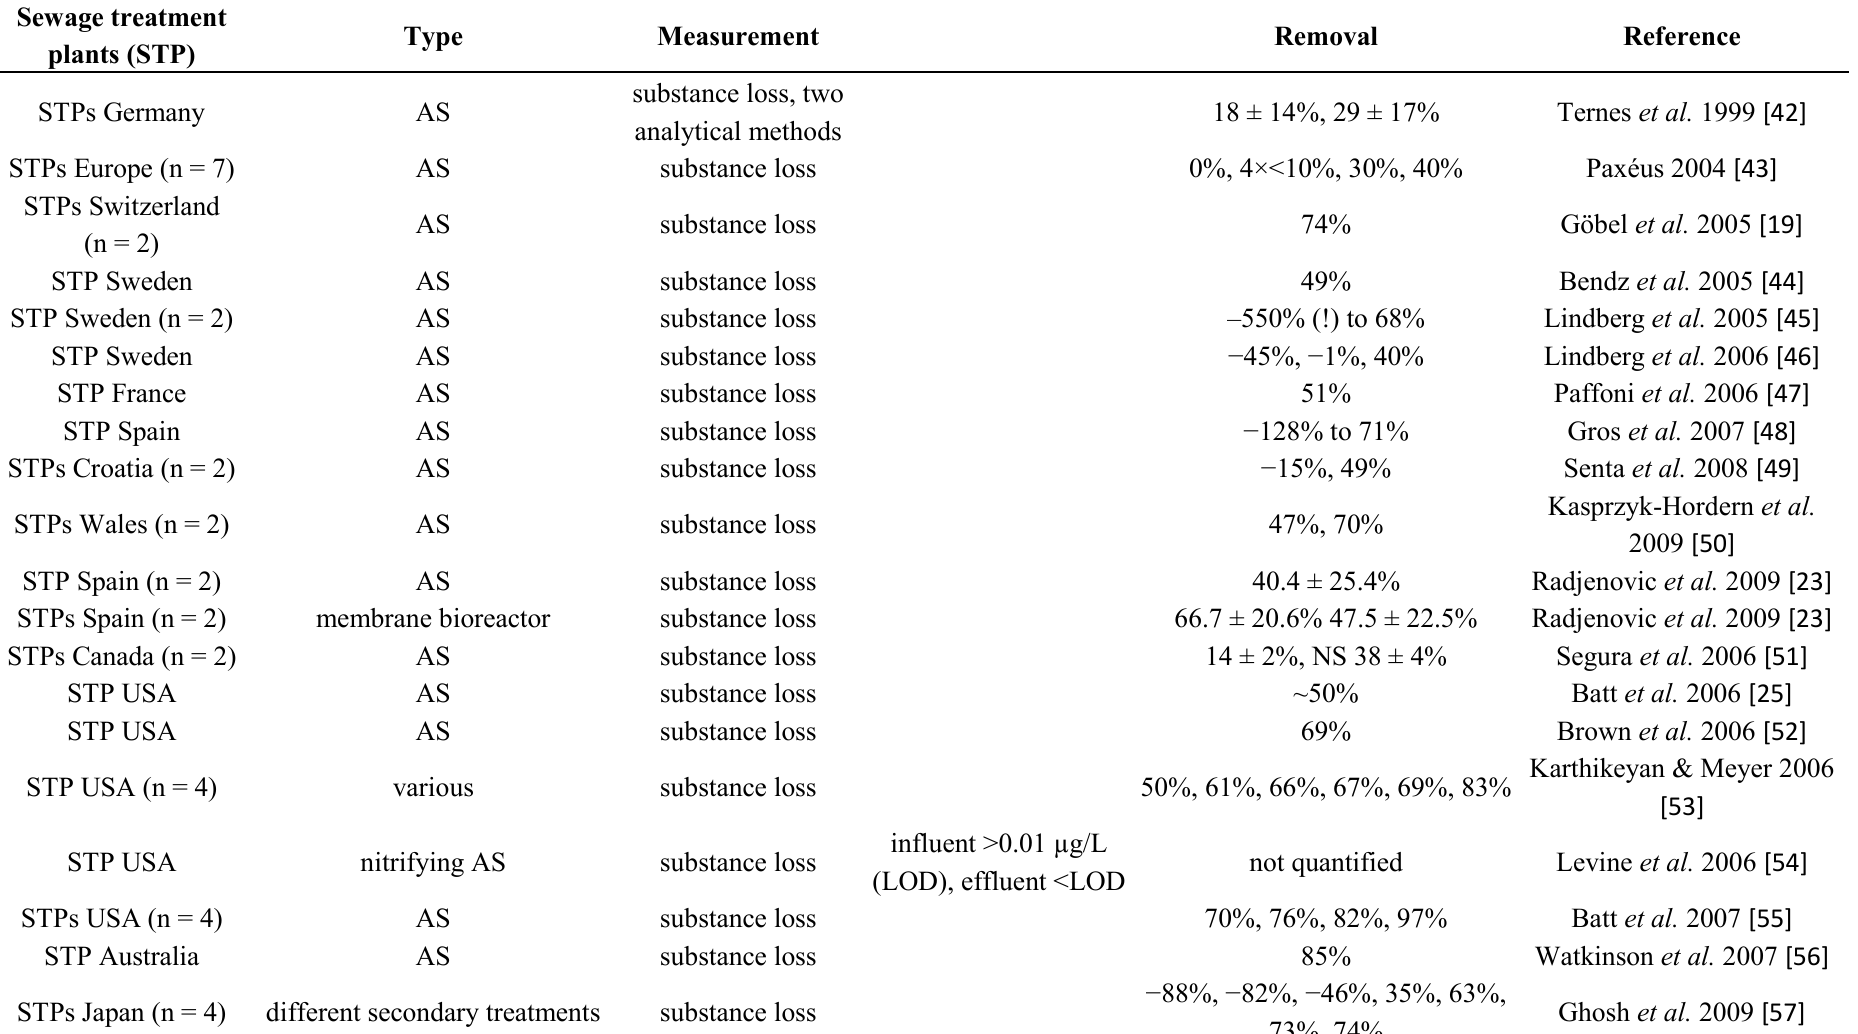
Table A3. Removal of TMP during sewage